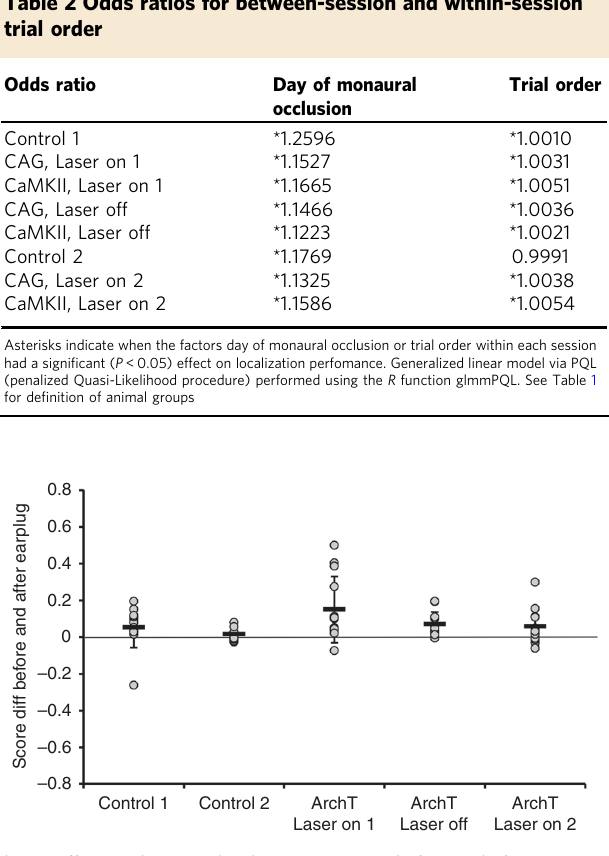
Fig. 5 Difference between localization accuracy before and after monaural occlusion. The difference between the proportion of correct responses is shown for individual animals prior to plugging one ear and following removal of the earplug. The control group of ferrets underwent two periods of training (Control 1, n = 13, and Control 2, n = 9), whereas the animals in which ArchT was expressed in high-frequency A1 received three blocks of training whilst wearing an earplug, with laser light delivered to the implanted optical fi ber on each trial during the fi rst (ArchT laser on 1, n = 13) and third block (ArchT laser on 2, n = 12), but not during the second block (ArchT laser off, n = 13). The gray symbols represent data from individual animals, and the tick marks and error bars indicate the mean ± SD. Source data are provided as a Source Data fi le